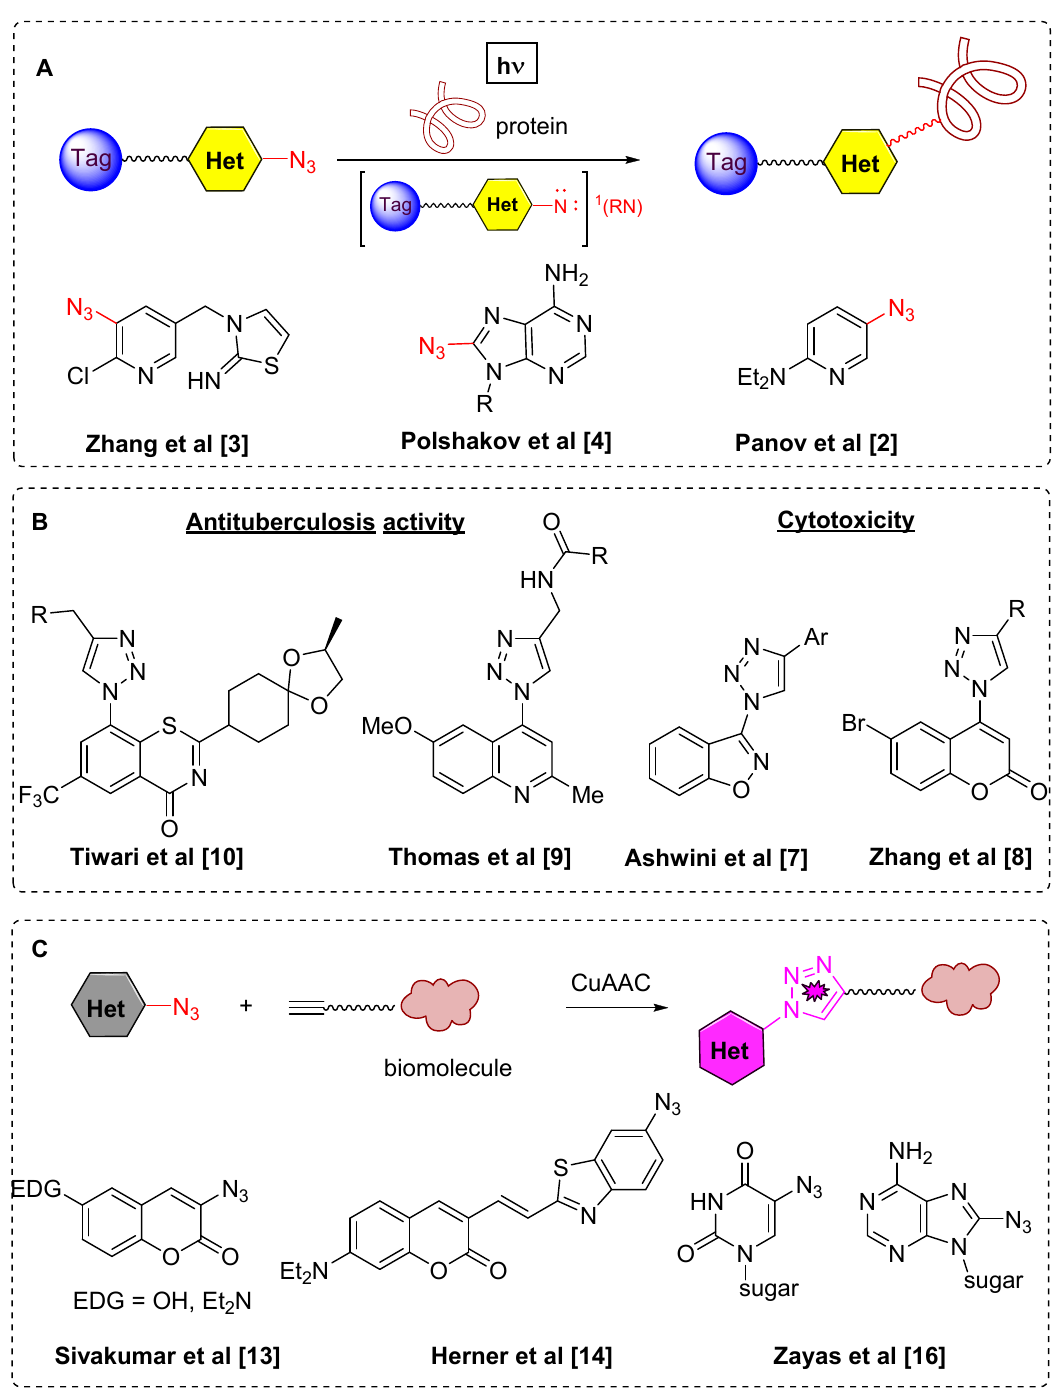
Figure 1. Recent areas of azidoheterocycles and triazolylheterocycles application–photoaffinity labeling ( A ); biologically-active compounds ( B ); fluorogenic azides ( C ). use ref numbers not years